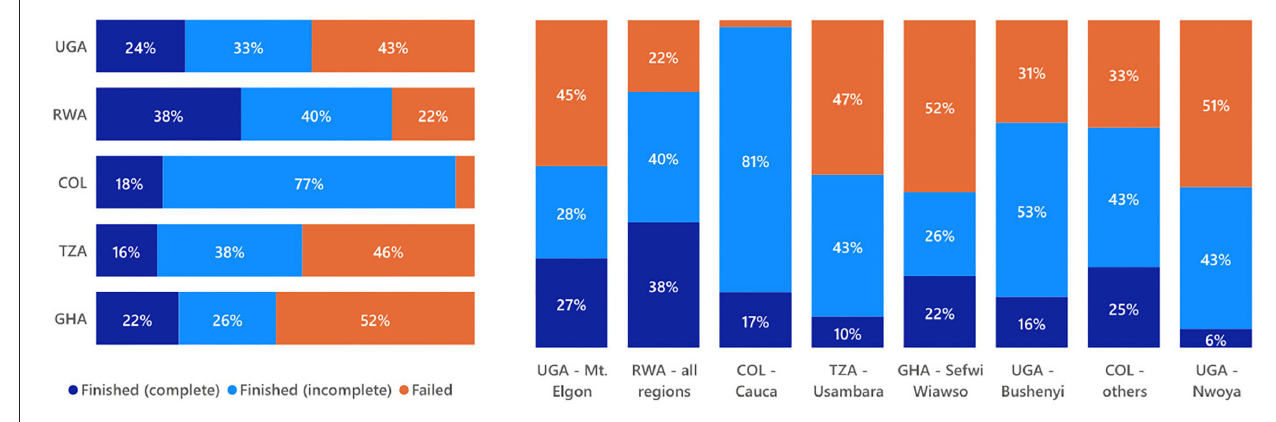
FIGURE 3 | Call status per country (left), and regions per country (right).